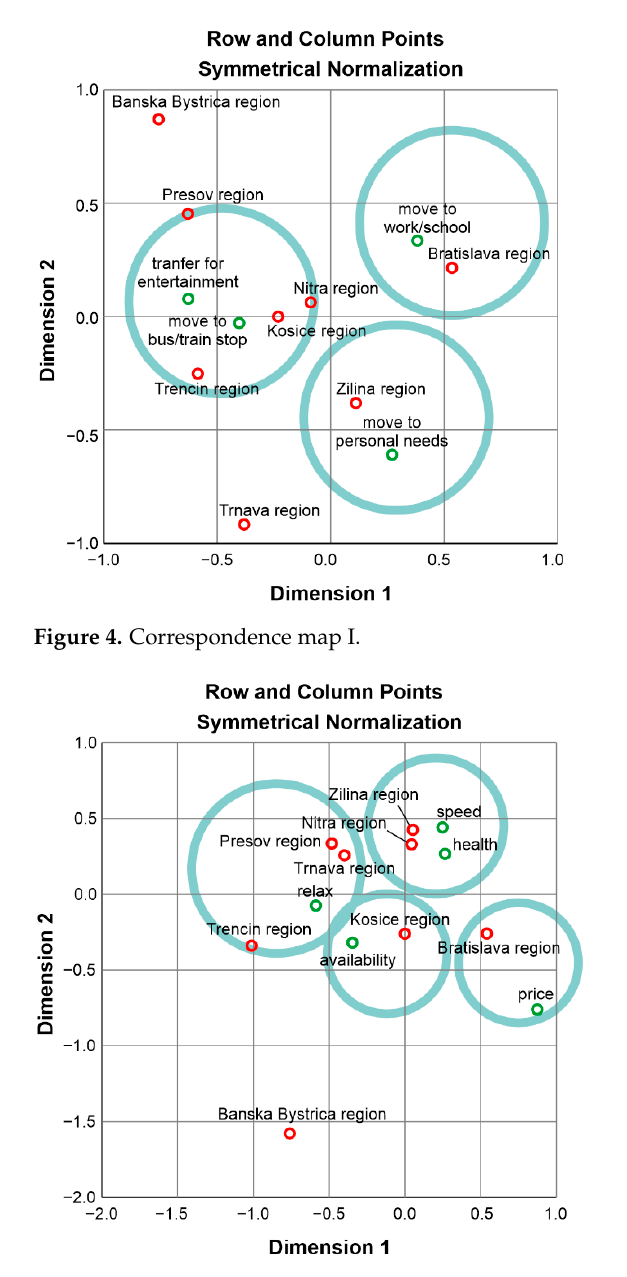
8 of 15 Table 5. Pearson chi-square test. No.